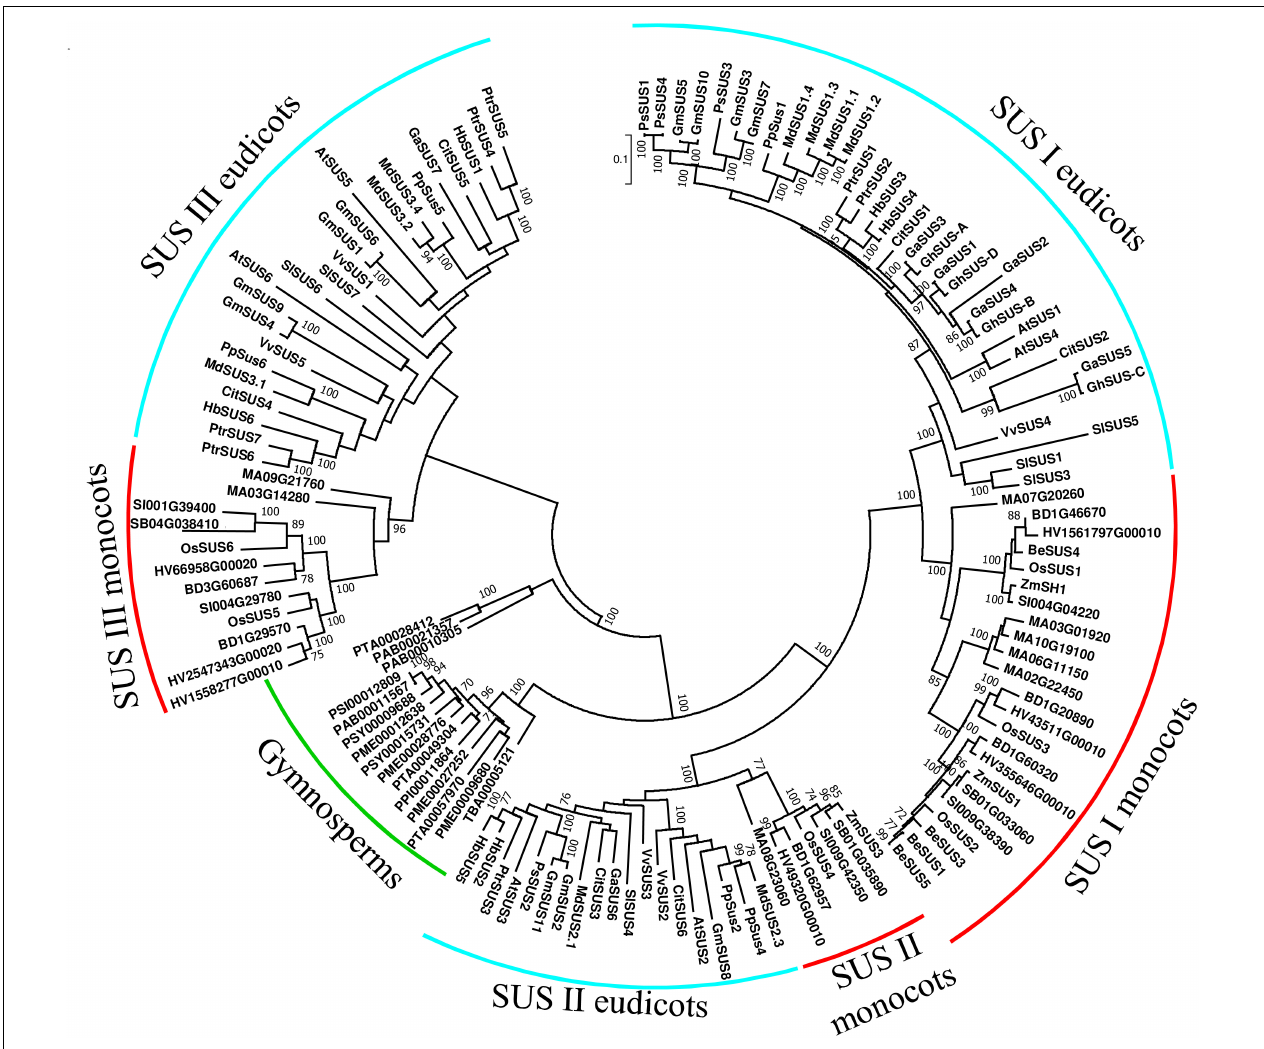
FIGURE 2 | Phylogenetic tree of SUS genes from land plants. SuSy amino acid sequences were obtained from PUBMED using gene or protein IDs from previous studies (Baud et al., 2004; Hirose et al., 2008; Chen et al., 2012; Xiao et al., 2014; Zhang et al., 2015; Zhu et al., 2017; Abdullah et al., 2018; Huang et al., 2018; Tong et al., 2018). Additional amino acid sequences were retrieved using the Plaza 3.0 tool for gene-family analysis (Van Bel et al., 2017) using “sucrose synthase” in a keyword search. Partial sequences and sequences with substantial deletions were excluded, leaving a total of 133 sequences ( Supplementary File 1 ). Sequences were aligned using MUSCLE with default options and analyzed in MEGA 7.0 (Kumar et al., 2016). The tree was created using the maximum-likelihood method based on the JTT matrix-based model (Jones et al., 1992). Bootstrap values > 70% are denoted at the nodes. Gymnosperm species are labeled with a green arc. Turquoise arcs indicate eudicot species and red arcs indicate monocot